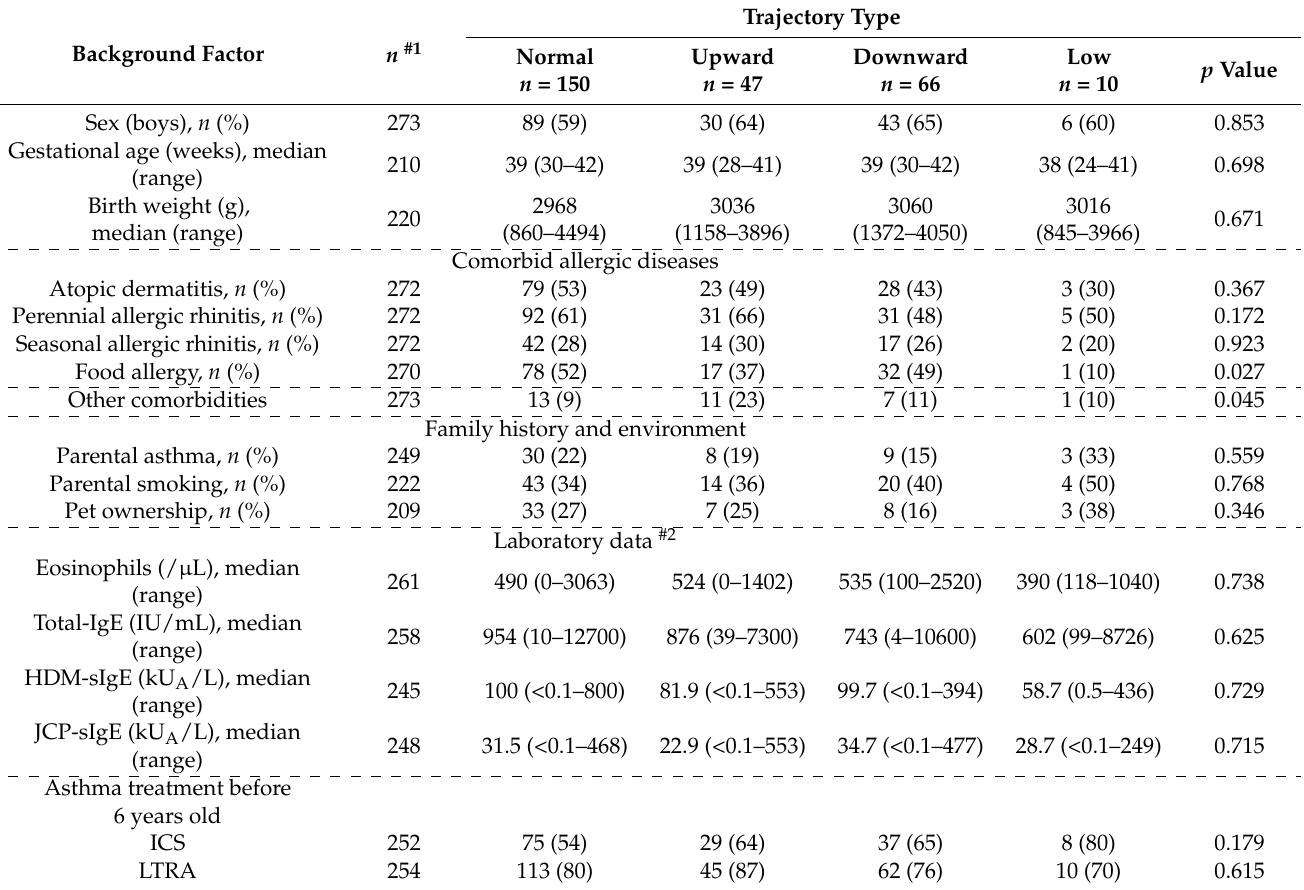
Table 1. Clinical background of the